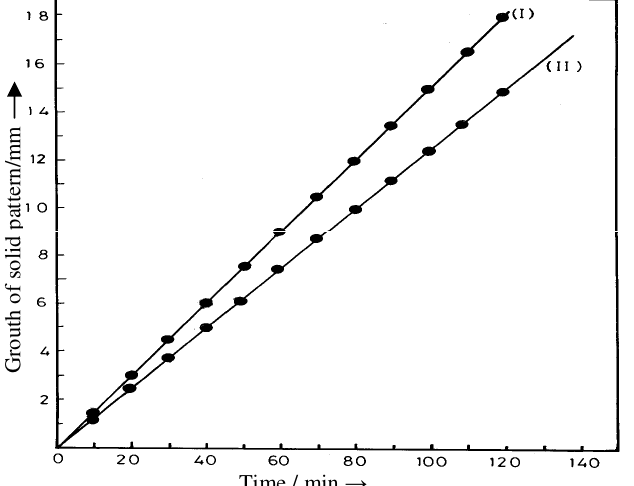
Figure 4 . Growth of trees / bushes pattern against time. Concentration and conditions are same as in Figure 1. l = vertical growth, II = horizontal